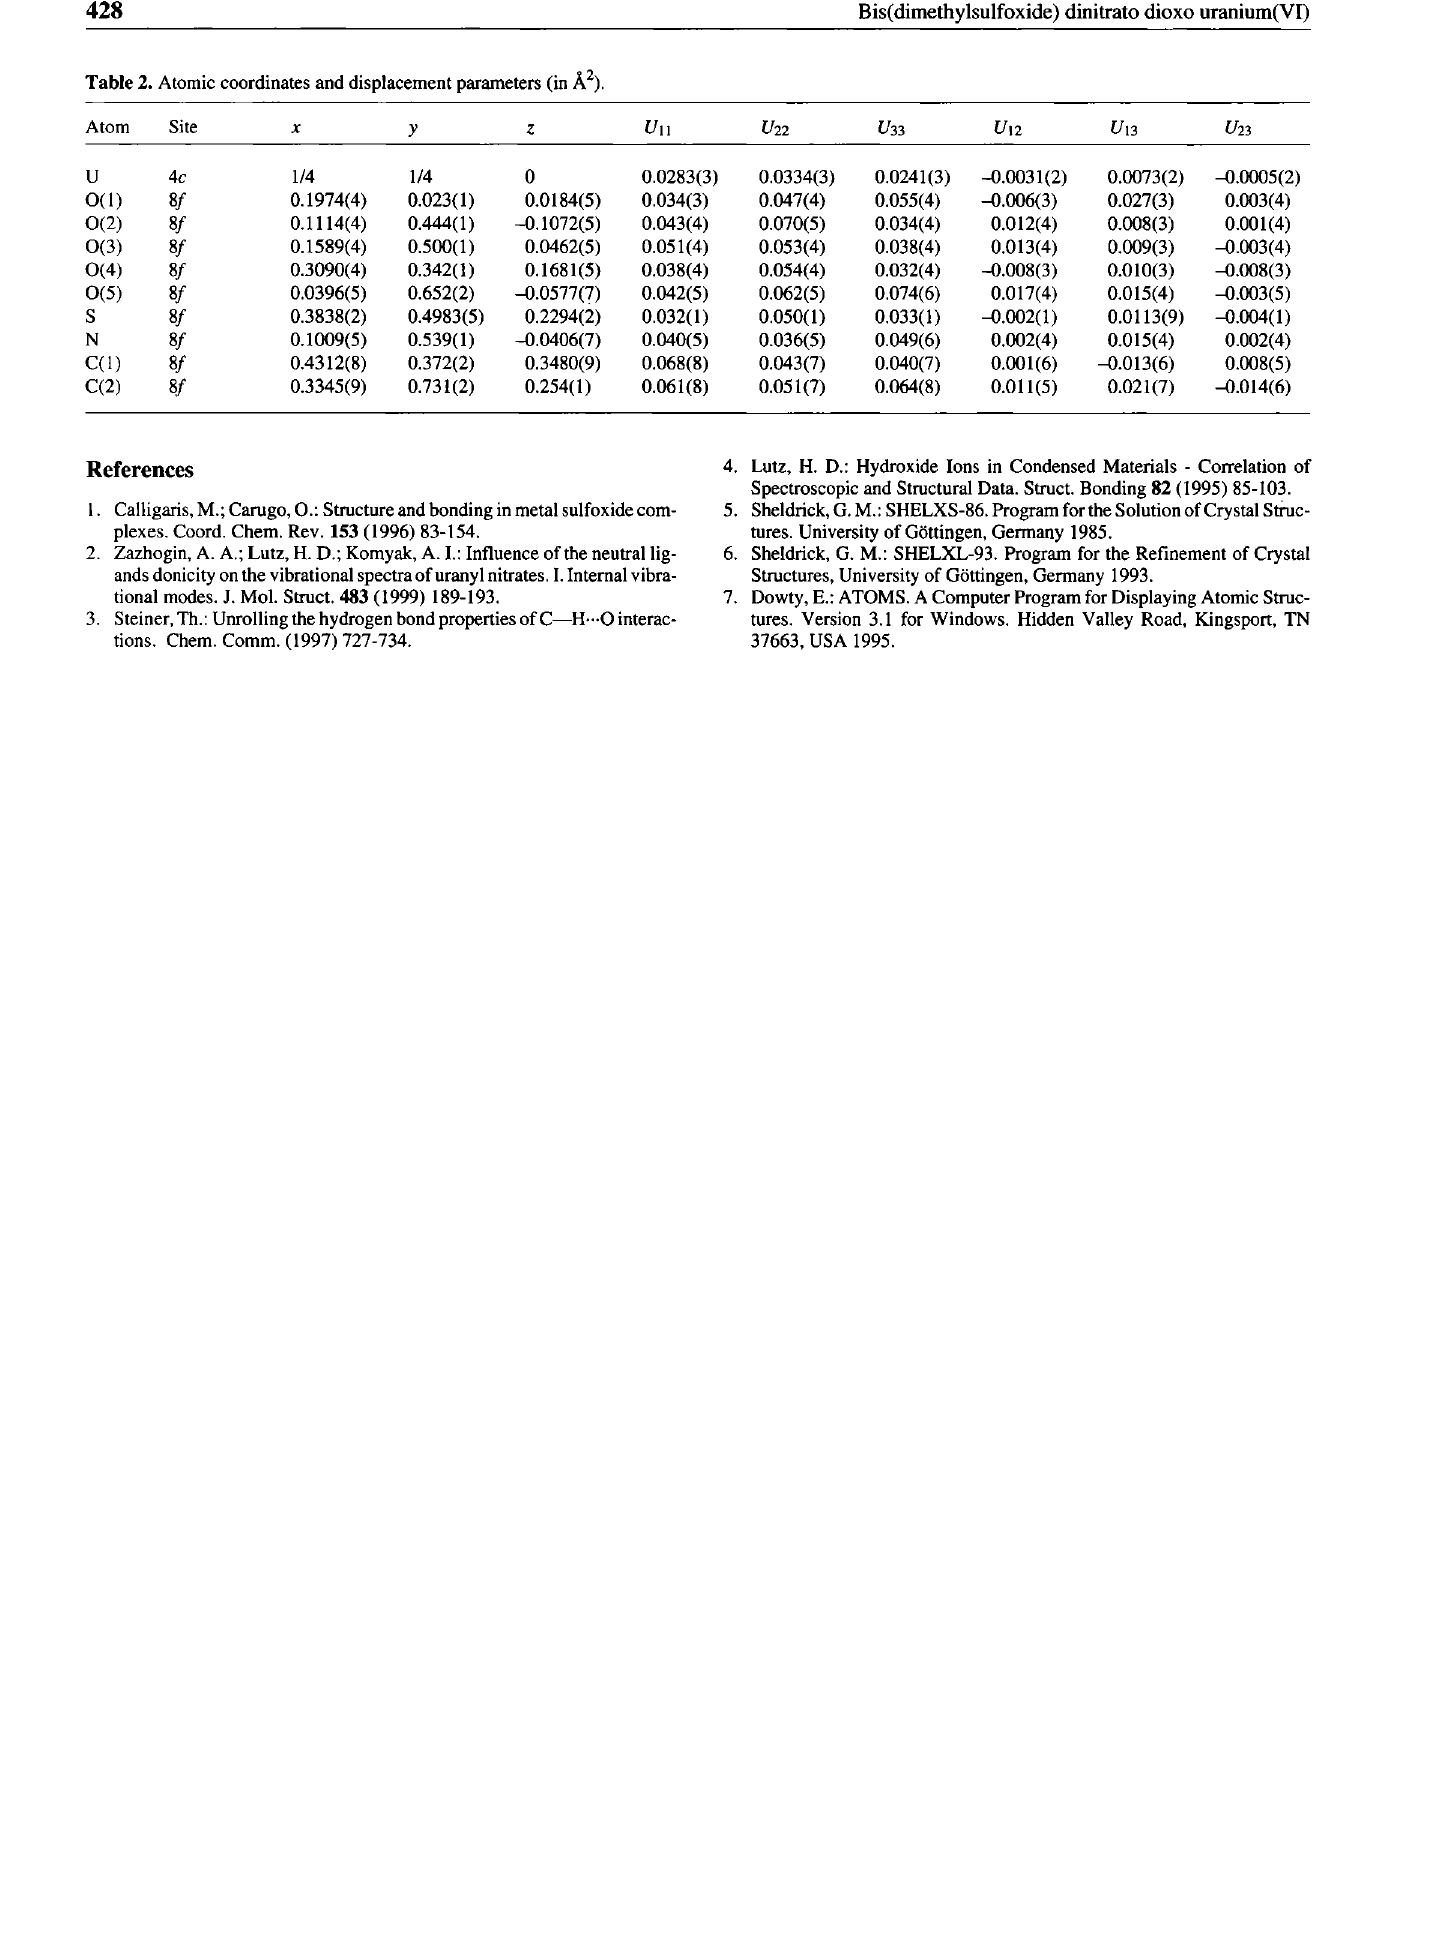
Table 2. Atomic coordinates and displacement parameters (in A 2